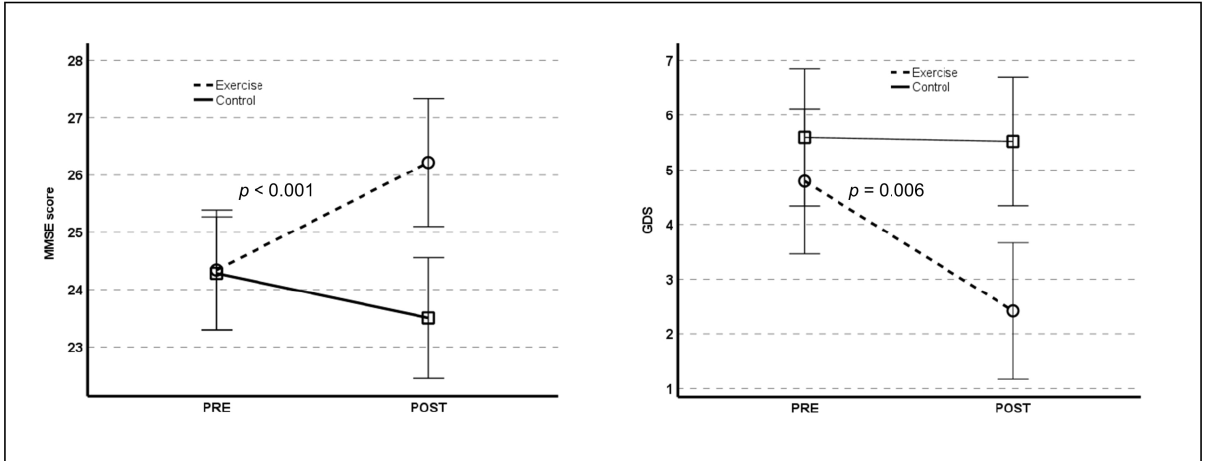
Figure 2. Time-by-group interactions for cognitive function ( left ) and depressive symptoms ( right ). MMSE: Mini – Mental state examination; GDS: geriatric depression scale.